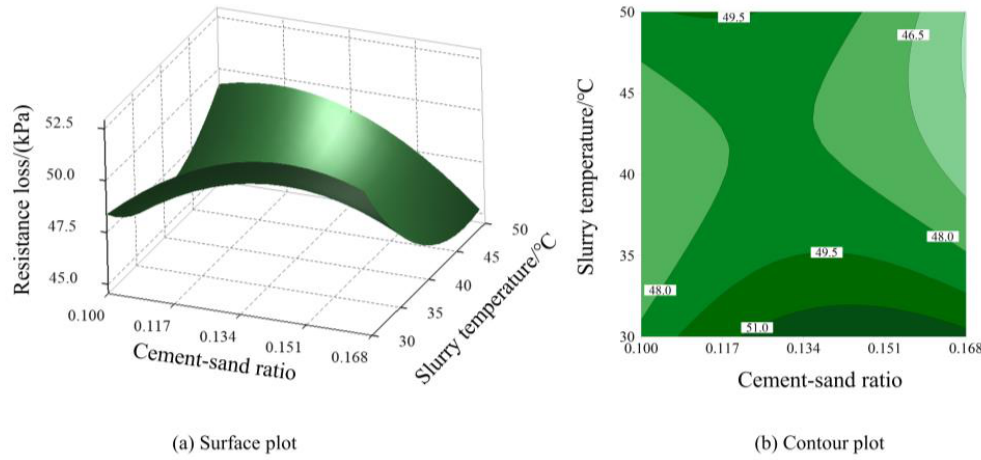
Figure 10. Interaction of cement – sand ratio and slurry temperature with resistance loss: the other factor is held at the center level.